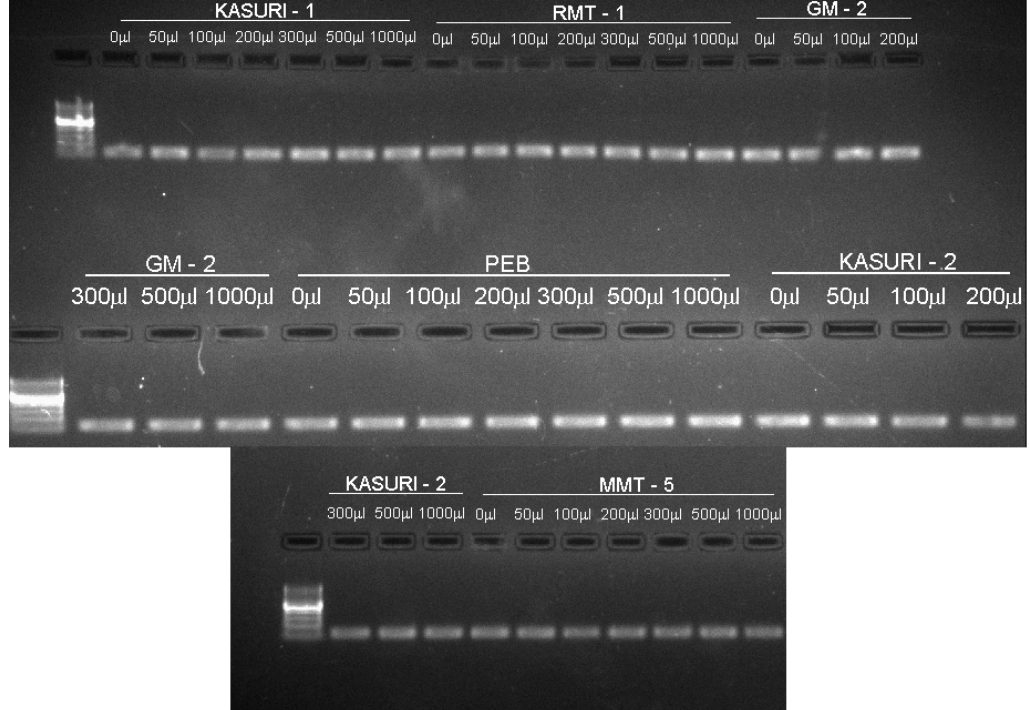
Figure 1. Electrophoretogram of amplified products generated for first strand complementary DNA (cDNA) from total RNA of methyl jasmonate (MeJA)-treated and control fenugreek ( Trigonella foeum-graecum L.) plants using 18 housekeeping gene primers, analysed using 2% agarose gel electrophoresis. Table 1. Primer details of 3-hydroxy-3-methylglutaryl-CoA reductase ( HMG ), sterol-3- β -glucosyl transferase ( STRL ) and 18S housekeeping genes.